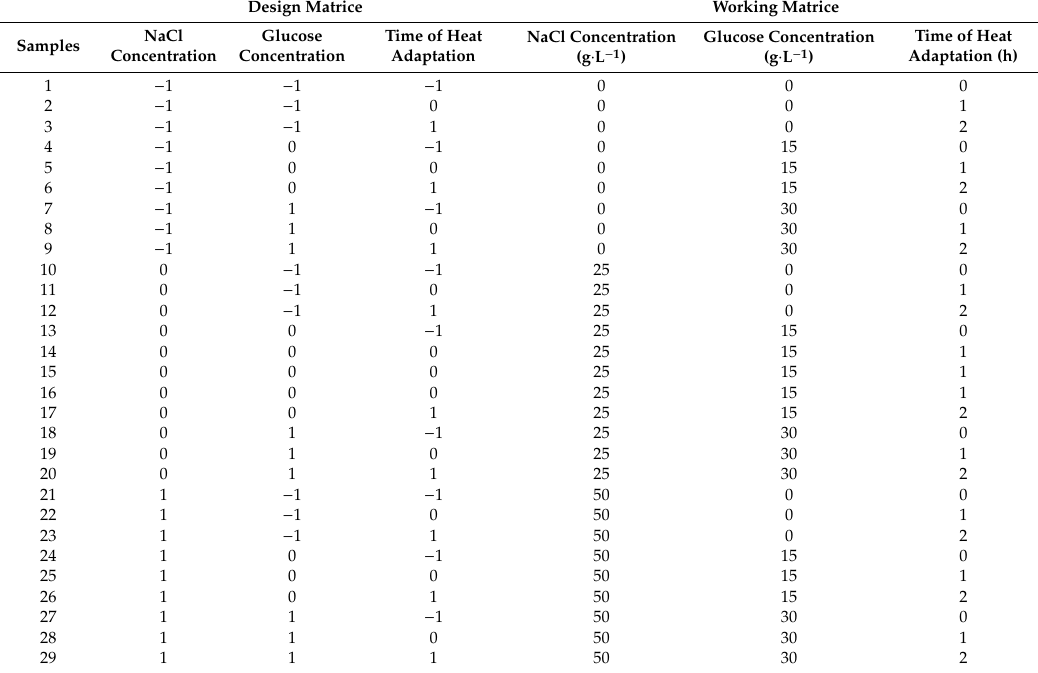
Table 1. Arrangement of the experimental design for the three independent variables used and their level. Design Matrice Working Matrice Samples